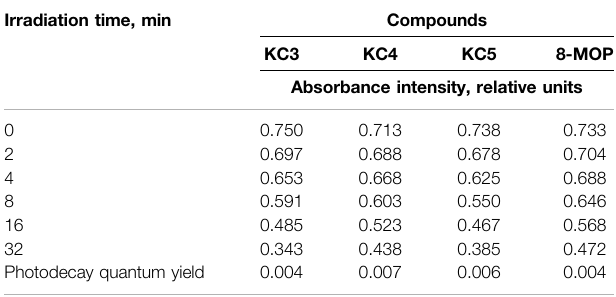
TABLE 5 | Absorbance intensity and photodecay quantum yield of compounds under the irradiation of XeCl* excilamp. Irradiation time,